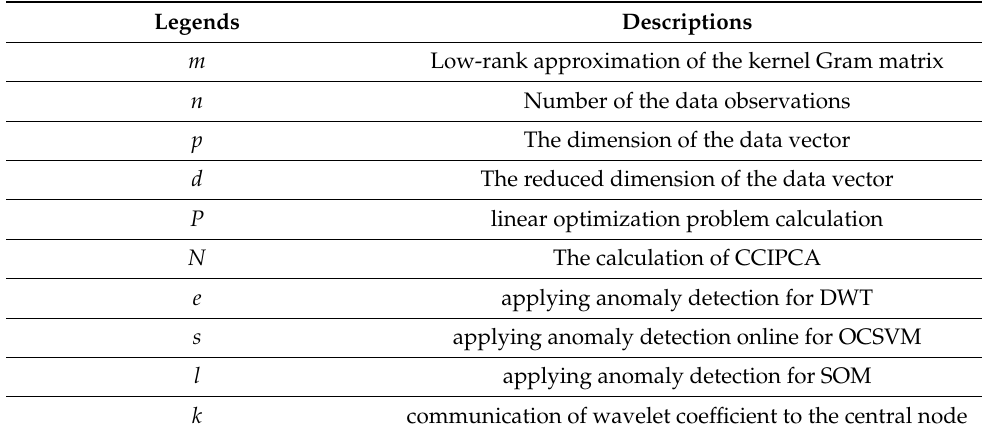
Table 5. The description of efficiency